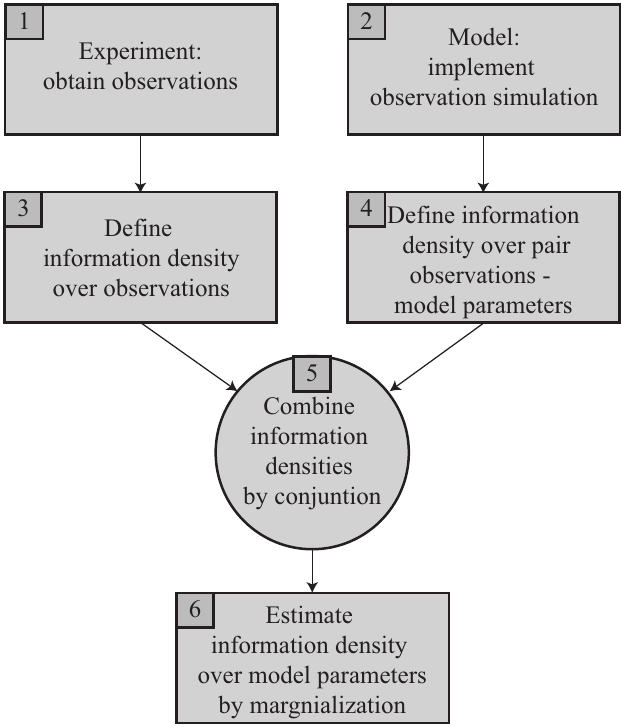
Figure 1. Conceptual framework of the basic information-theoretic probabilistic inverse